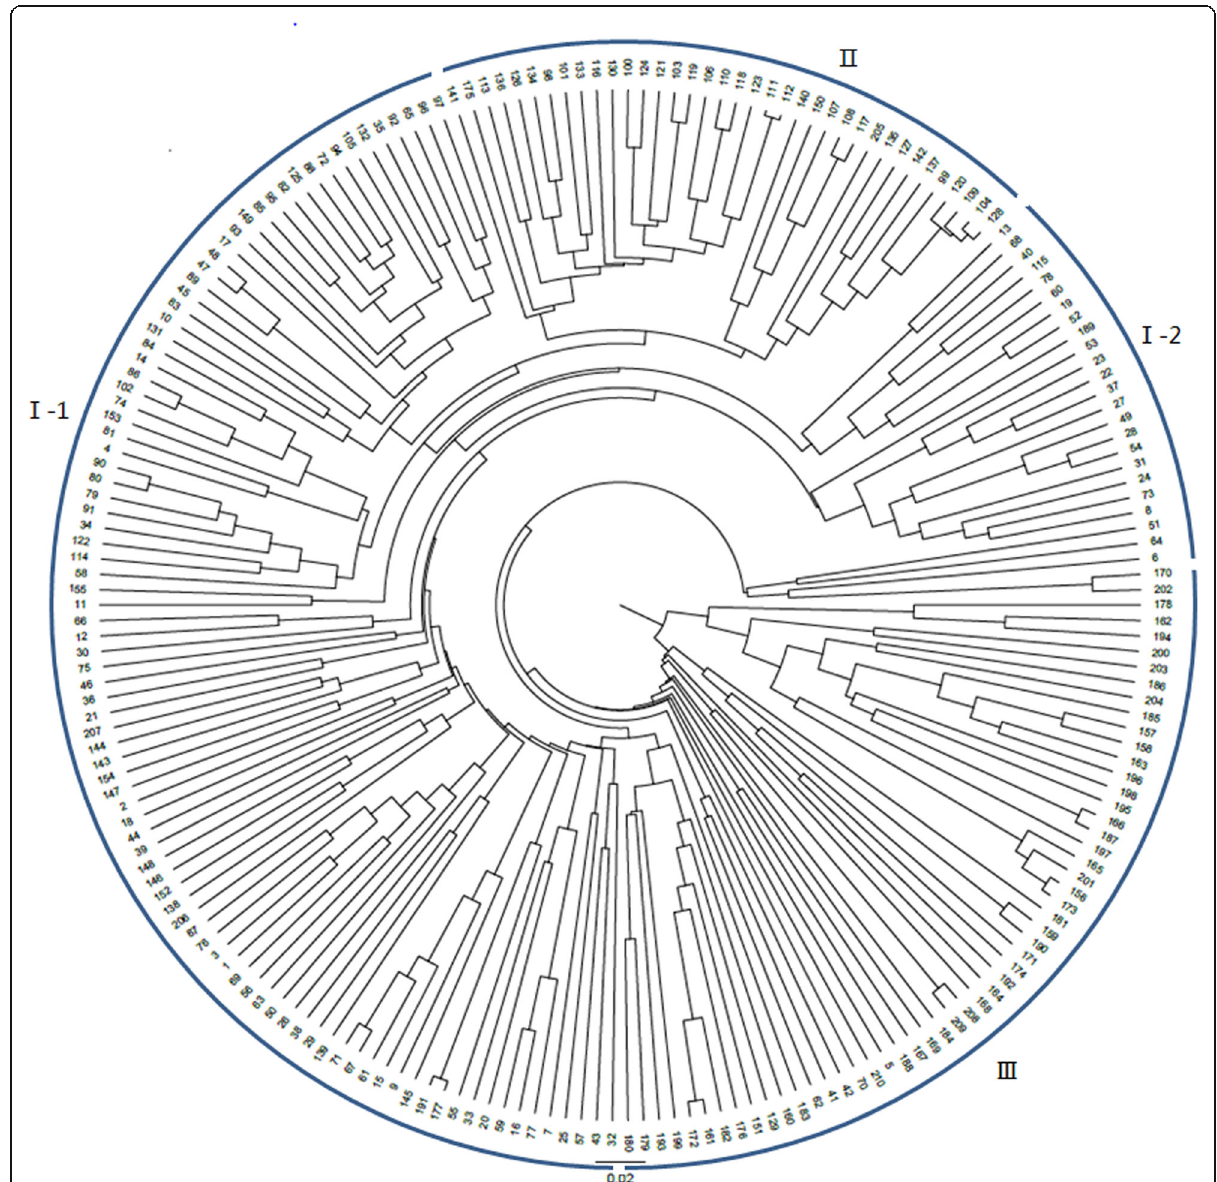
Fig. 3 UPGMA clustering analysis of 210 varieties. Group I: mainly from Yellow River basin; group II: mainly from Yangtze river basin; group III: mainly from the northwest upland cotton-growing